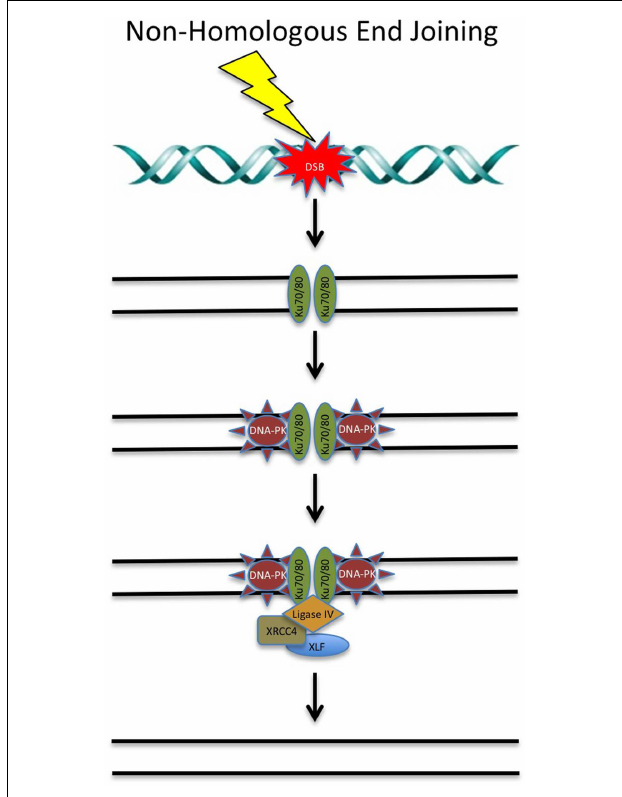
FIGURE 2 | DNA double-strand break repair via non-homologous end joining . DSBs can be repaired via NHEJ throughout the cell cycle.Targeting of these proteins involved in NHEJ with chemotherapeutic compounds shows promise in the clinical setting. See text for